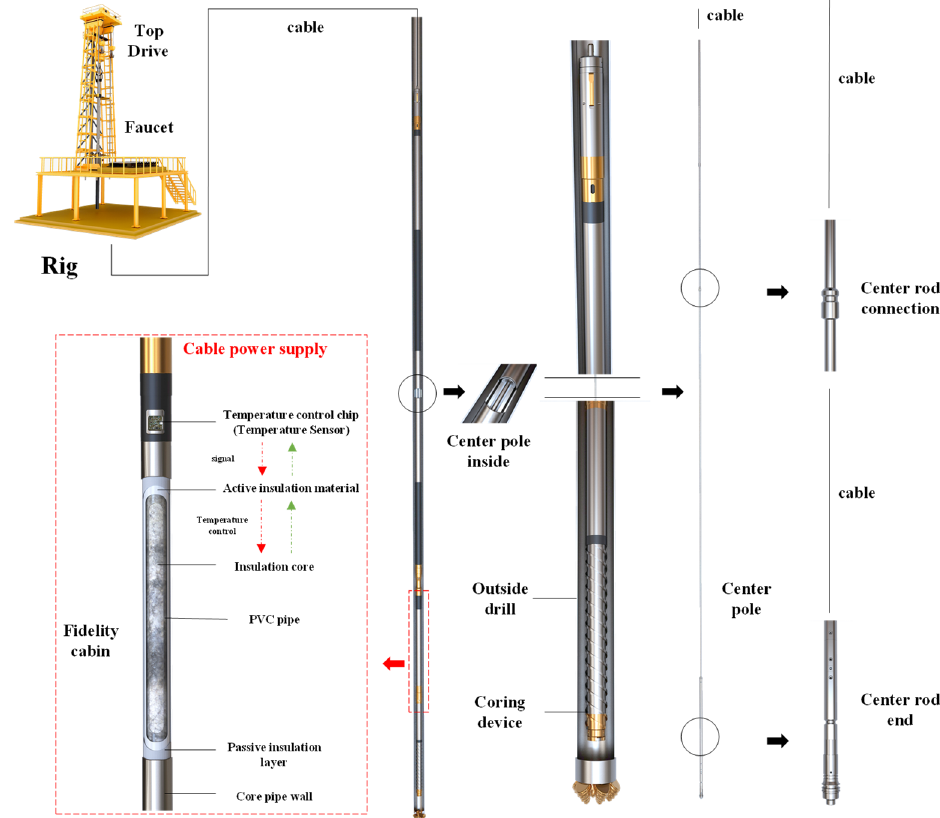
Figure 6. The position and workflow of the center pole.